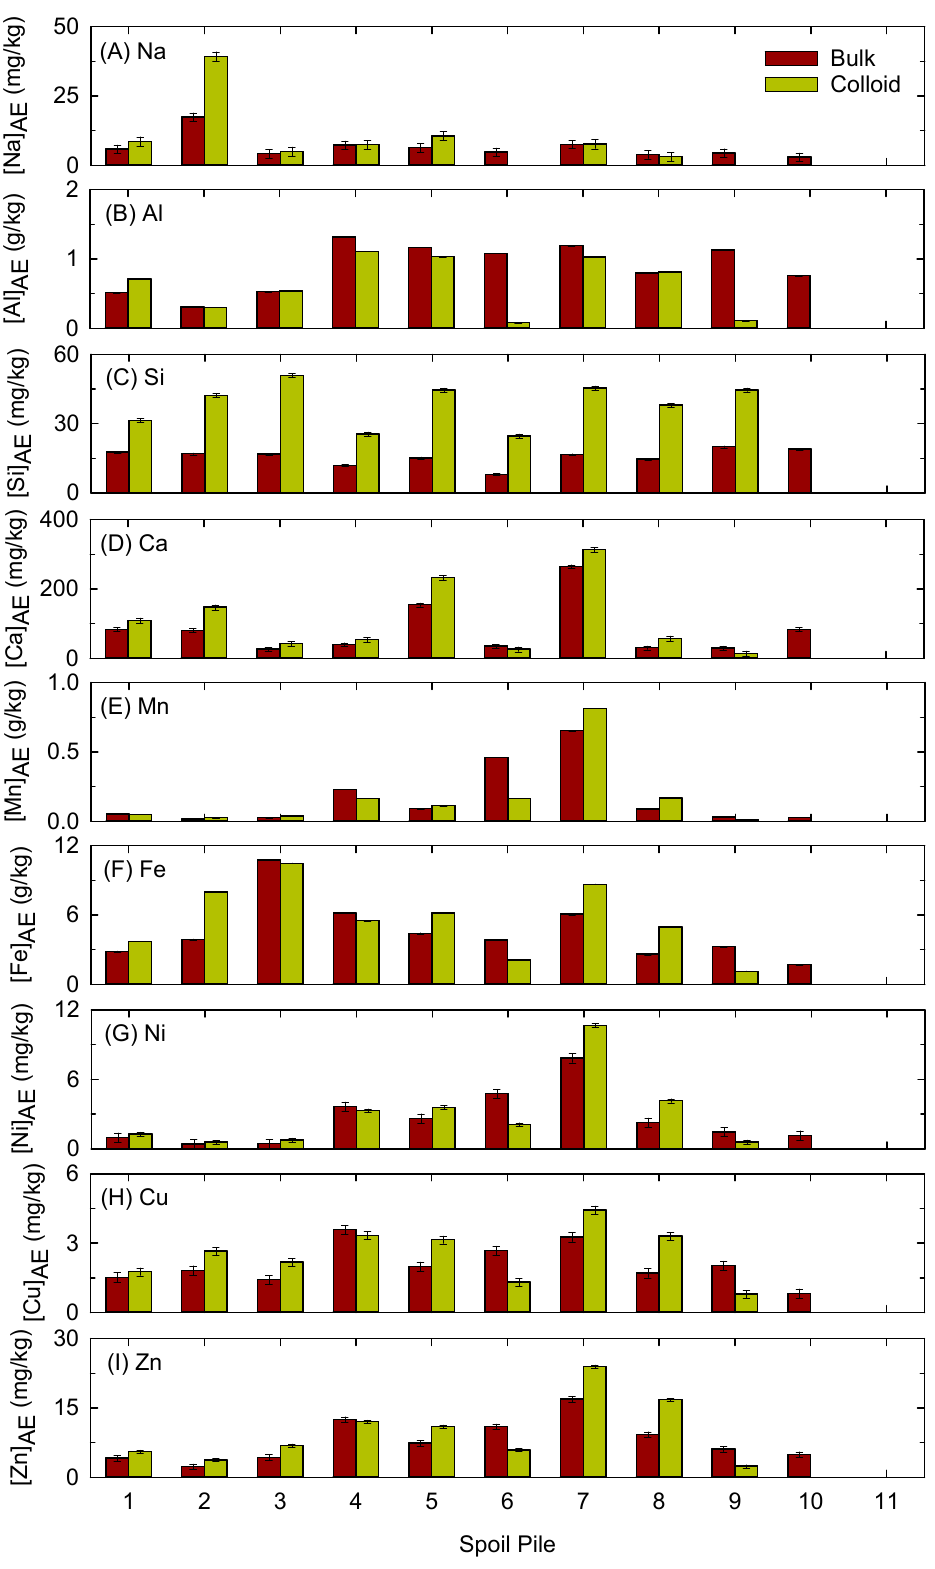
Figure 8. Acid ‐ extractable Na ( A ), Al ( B ), Si ( C ), Ca ( D ), Mn ( E ), Fe ( F ), Ni ( G ), Cu ( H ), and Zn ( I ) concentrations of bulk mine spoil (red bars) and mine spoil colloids (yellow bars) with analytical errors (which are small enough in some cases to not be visualized). Values for Al, Mn, and Fe are reported as g/kg; the rest are reported as mg/kg. Bars not shown represent analytes below the detection limit.